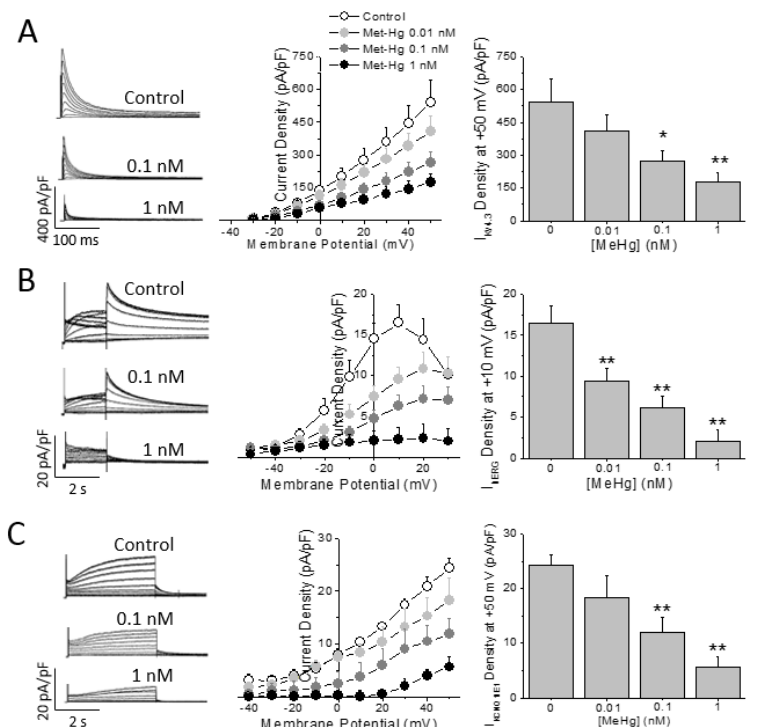
Figure 4. MeHg reduces repolarization capability in human cells in vitro. Representative traces and average current density-voltage relationships obtained in HEK293 cells expressing ( A ) Kv4.3 channels, ( B ) hERG channels, or ( C ) Kv7.1 / KCNE1 channels. MeHg acute exposure reduces all currents in a concentration dependent manner. n = 8–15 cells. * p < 0.05; ** p < 0.01.